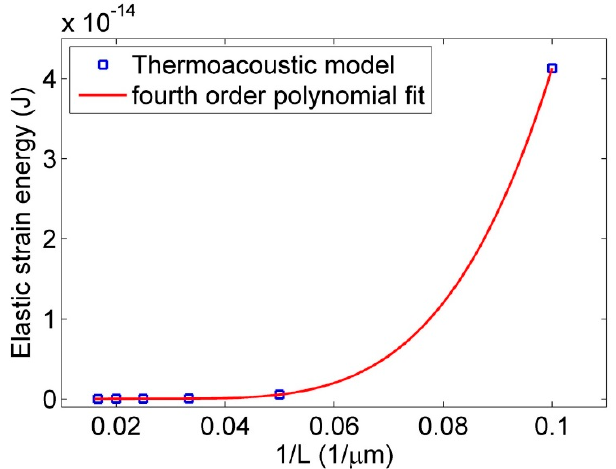
Figure 12. Effect of length on the elastic strain energy of nanowire. The analytical model matches the results of the thermoacoustic model ( V ∝ 1